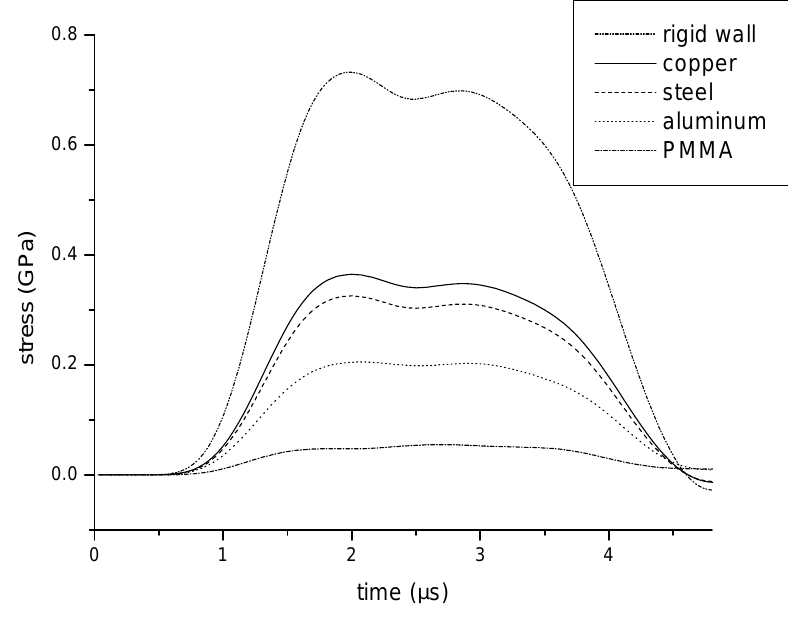
Fig. 3. Stress response in copper impactor for different targets (Case 1, 2).